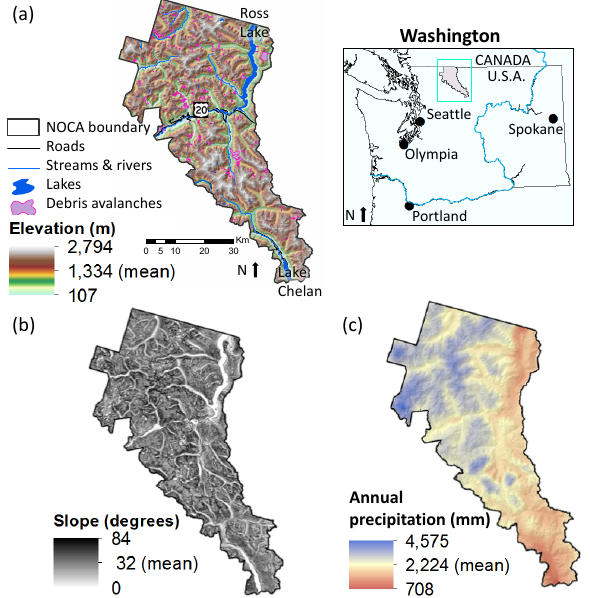
Figure 2. NOCA in northern Washington state, USA: (a) a 30m DEM of the domain overlain by debris avalanches and major water bodies; (b) slope derived from DEM; and (c) mean annual precipi- tation (1981–2010 average) mapped at 800m resolution from the Parameter-elevation Relationships on Independent Slopes Model (PRISM; Daly et al.,